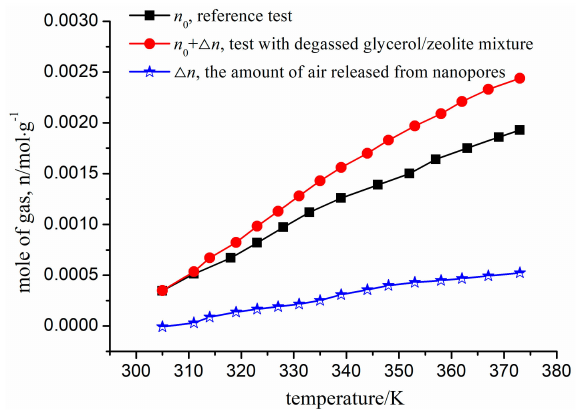
Figure 3. The amount of air released from nanopores with the increase of temperature after degassing